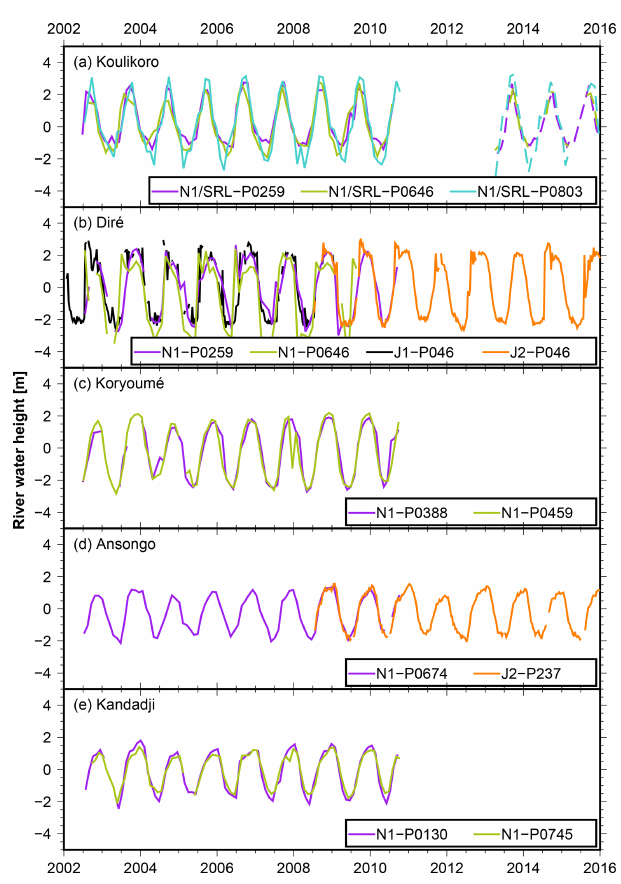
Figure 6. Time series of relative river heights for each investi- gated station. Legend composition: satellite (N1 for Envisat, SRL for SARAL/Altika, and J for Jason) and pass number (P).